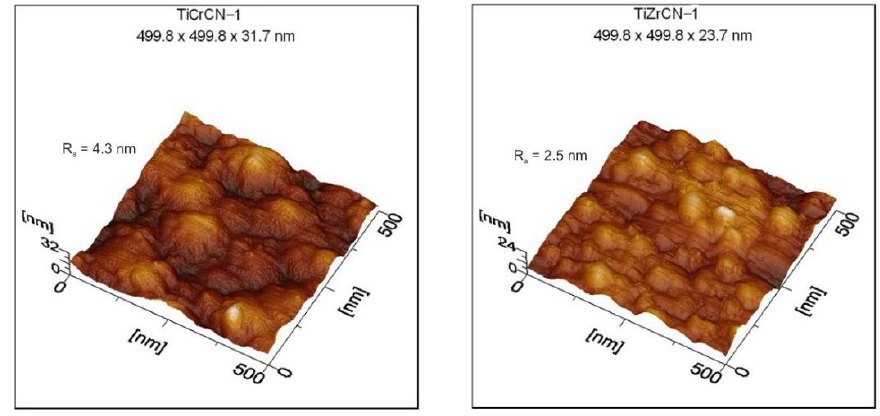
Figure 4. SPM images of the topography of deposited TiCrCN-1 and TiZrCN-1coatings on titanium VT1-0.